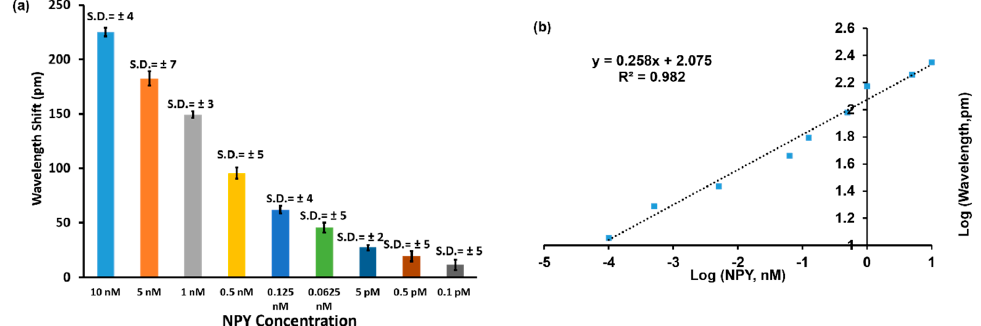
Figure 6. ( a ) Bar chart of wavelength shift vs. NPY concentration. ( b ) Log-log plot of wavelength shift versus concentration. The logarithmic transformation was applied to establish a linear relationship for the concentration range from 0.1 pM to 10 nM of NPY.